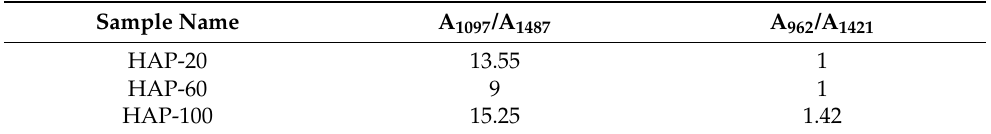
Table 3. Values of absorbance ratios A 1097 /A 1487 and A 962 /A 1421 as obtained from the spectra of HAp nanopowders at different pressures.